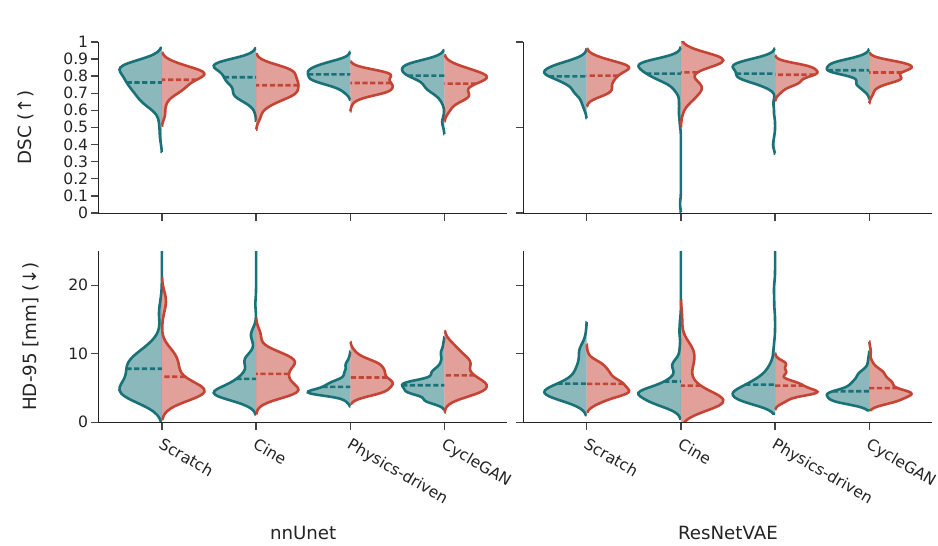
Figure 11. Comparative violin plots displaying the difference in performance metric distributions between control and DMD patients for each model for different model architectures and different pretraining strategies (with cine images, simulated tagged with physics-driven transformation, and simulated tagged with CycleGAN